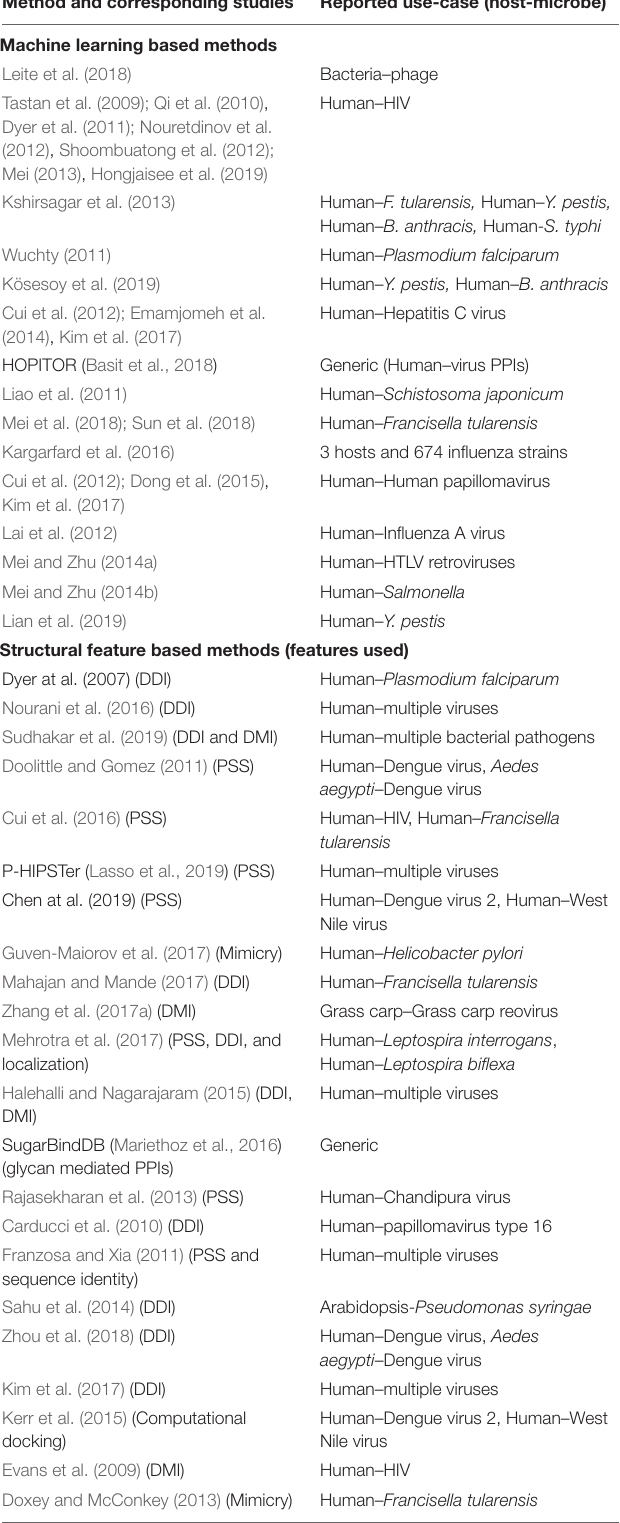
TABLE 2 | Computational approaches and methods inferring protein–protein interactions mediating inter-kingdom cross-talk between microbial and host